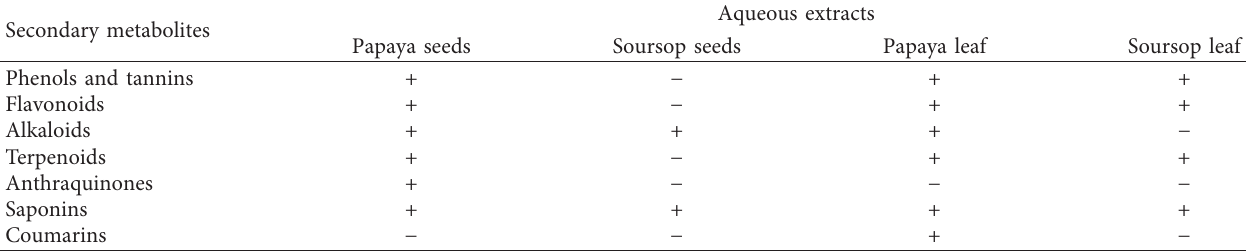
Table 2: Qualitative identification of secondary metabolites presents in aqueous extracts of papaya and soursop seed and leaf. Secondary metabolites